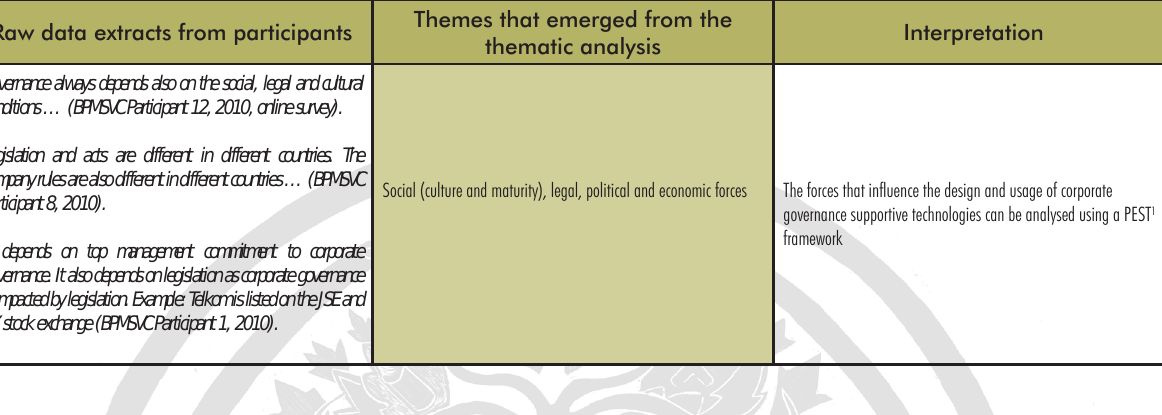
TABLE 1: DATA ANALYSIS OF FORCES THAT IMPACT THE DESIGN AND USAGE OF CORPORATE GOVERNANCE SUPPORTIVE TECHNOLOGIES Themes that emerged from the Raw data extracts from participants thematic analysis